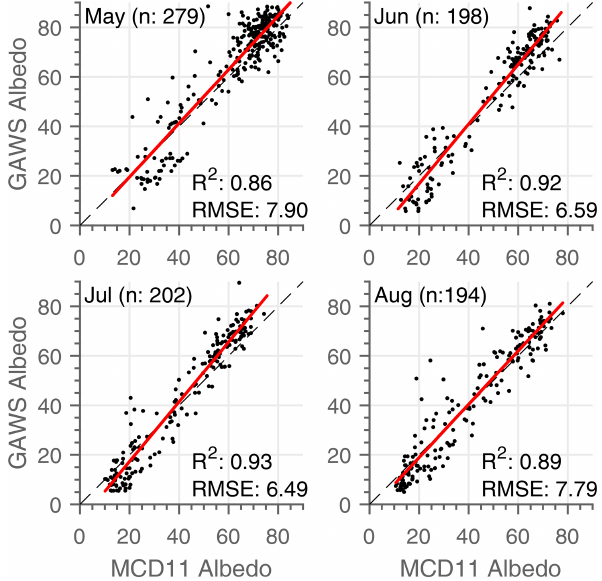
Figure 2. Comparison of monthly-averaged MODIS albedo with in situ GAWS albedo observations for May, June, July, and August for the period 2000–2019 where data were available for the MCD11 data